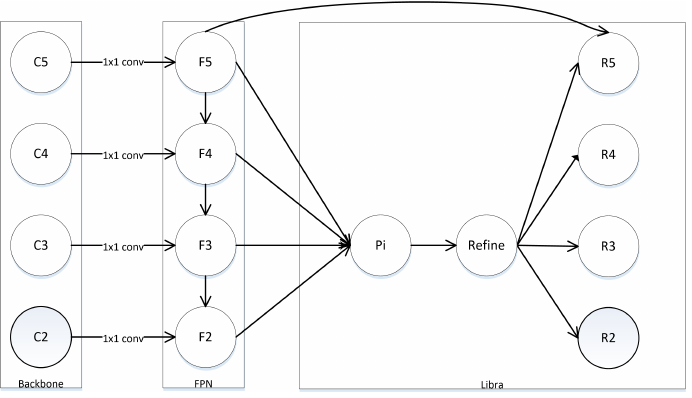
Figure 2. Libra RCNN’s BFP. BFP re-scale the output features of FPN into one size and use summation to fuse the features, then resize the output feature into different